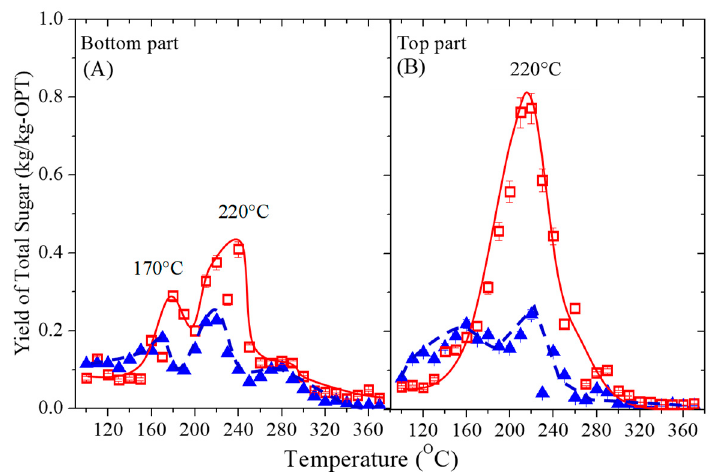
Figure 5. Effect of the reaction temperature on the yield of total sugar after OPT 21 ( □ ) and OPT 35 ( ▲ ) were subjected to a sub-CW treatment for 5 min. ( A ) Bottom and ( B ) top sections.